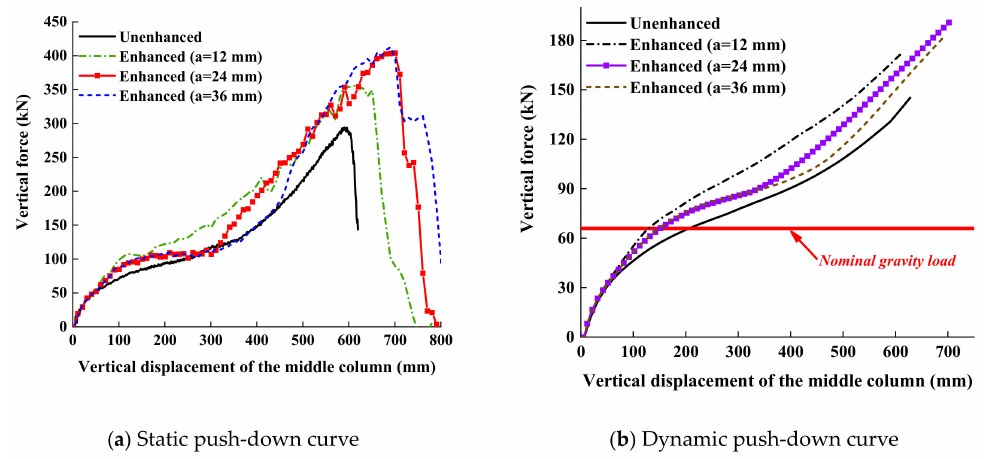
Figure 20. Comparison between the unenhanced and enhanced composite frame using retrofit strategy